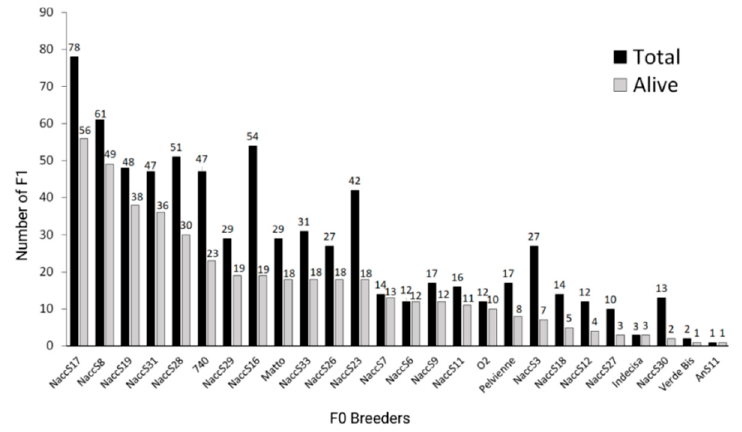
Figure 1. Contribution of the different F0 breeders to the F1 generation. For each breeder reproduced in the past, the total number of F1 in the analyzed stock and the ones still alive are reported (created with Biorender.com, accessed on 13 September